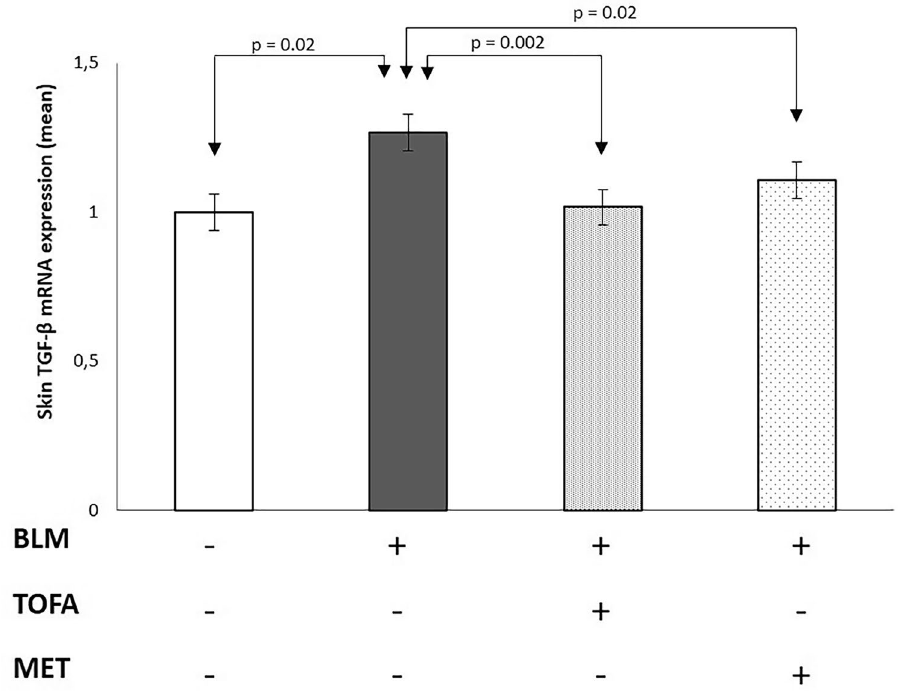
Figure 5. Skin transforming growth factor beta (TGF-β) messenger RNA expressions in the study